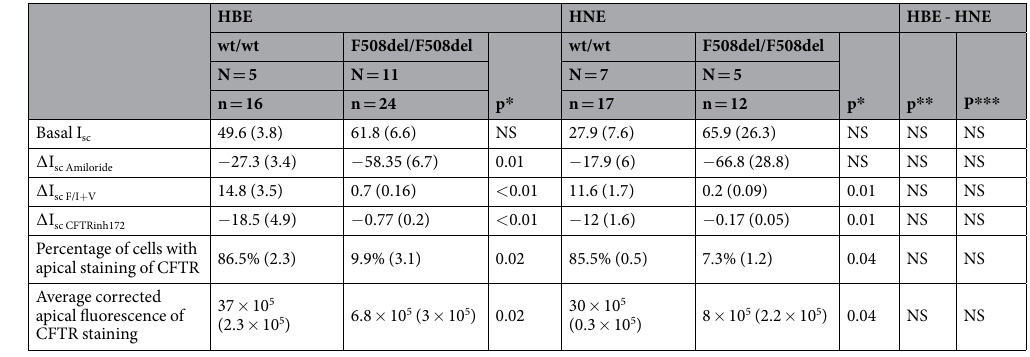
Table 1. Comparison of HBE and HNE cell cultures issued from healthy donors (wt/wt) and F508del homozygous patients (F508del/F508del). Mean ( ± SEM) were calculated from median values per patient. Comparison by non-parametric Mann-Whitney test. ∆ I sc results are expressed in µ A/cm 2 . Data are presented from n filters obtained from N subjects. At least 2 filters per patient were analyzed. p * : wt/wt –